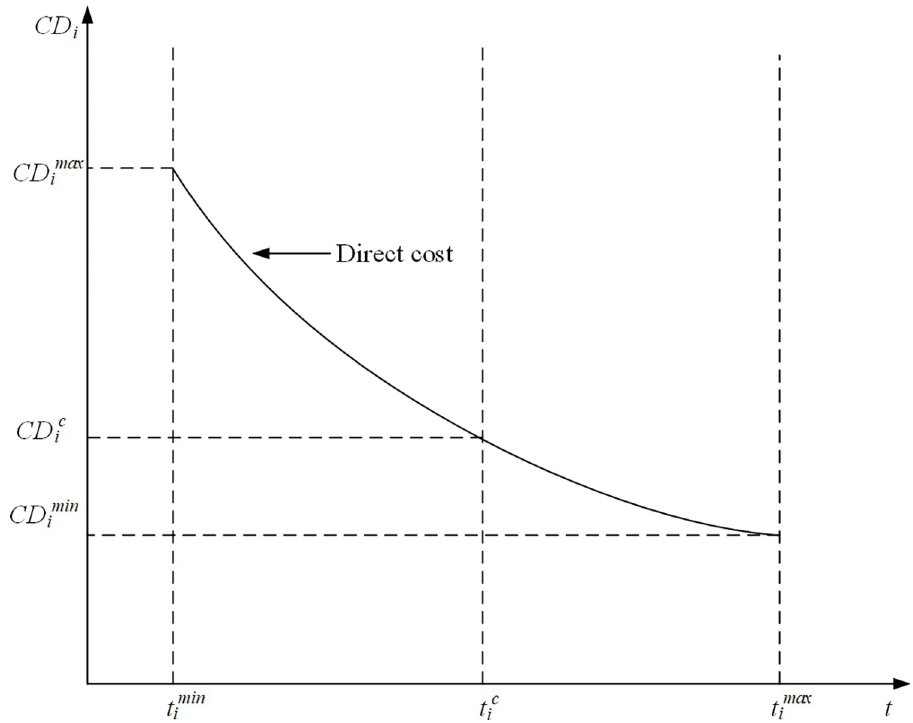
Fig 6. The curve of the relationship of time- direct